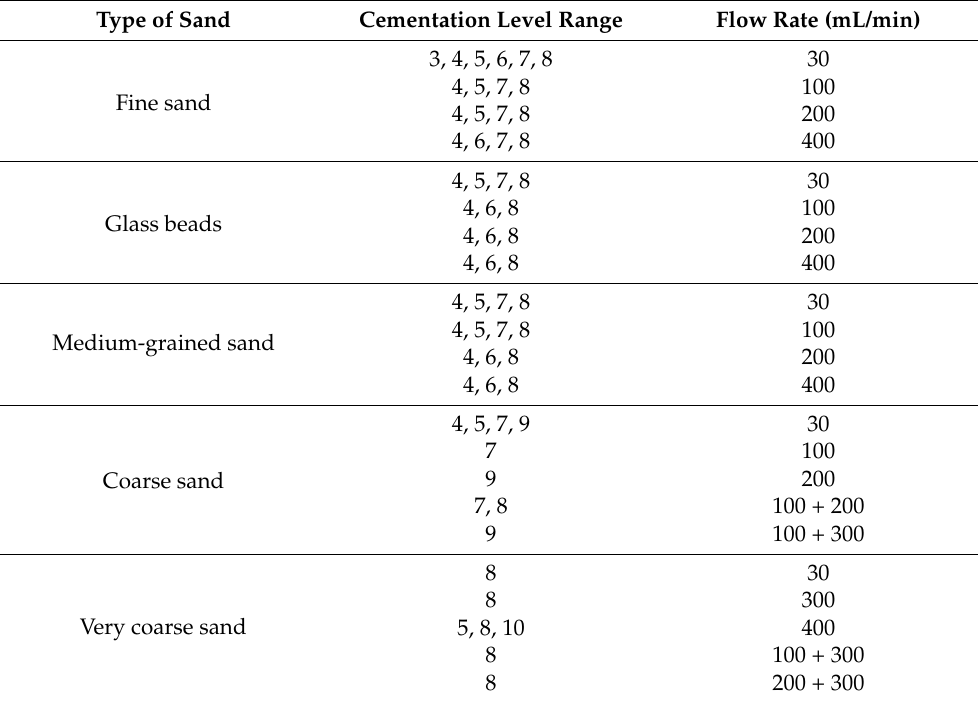
Table 2. The experimental program of the fluid injection